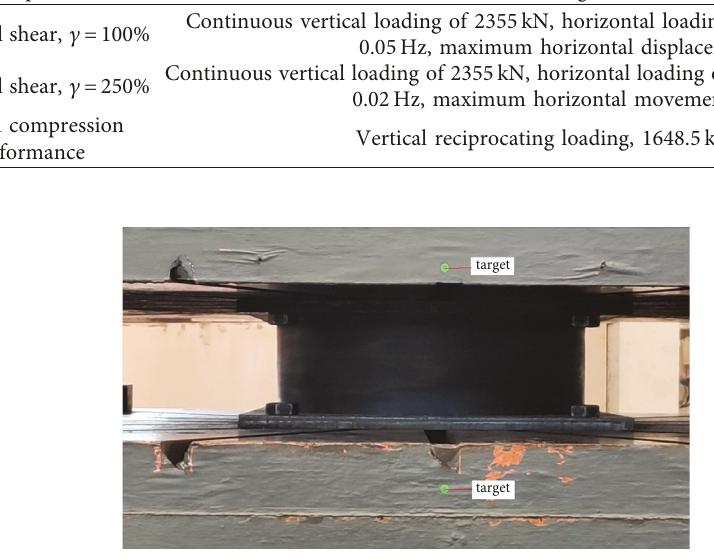
Figure 6: Target